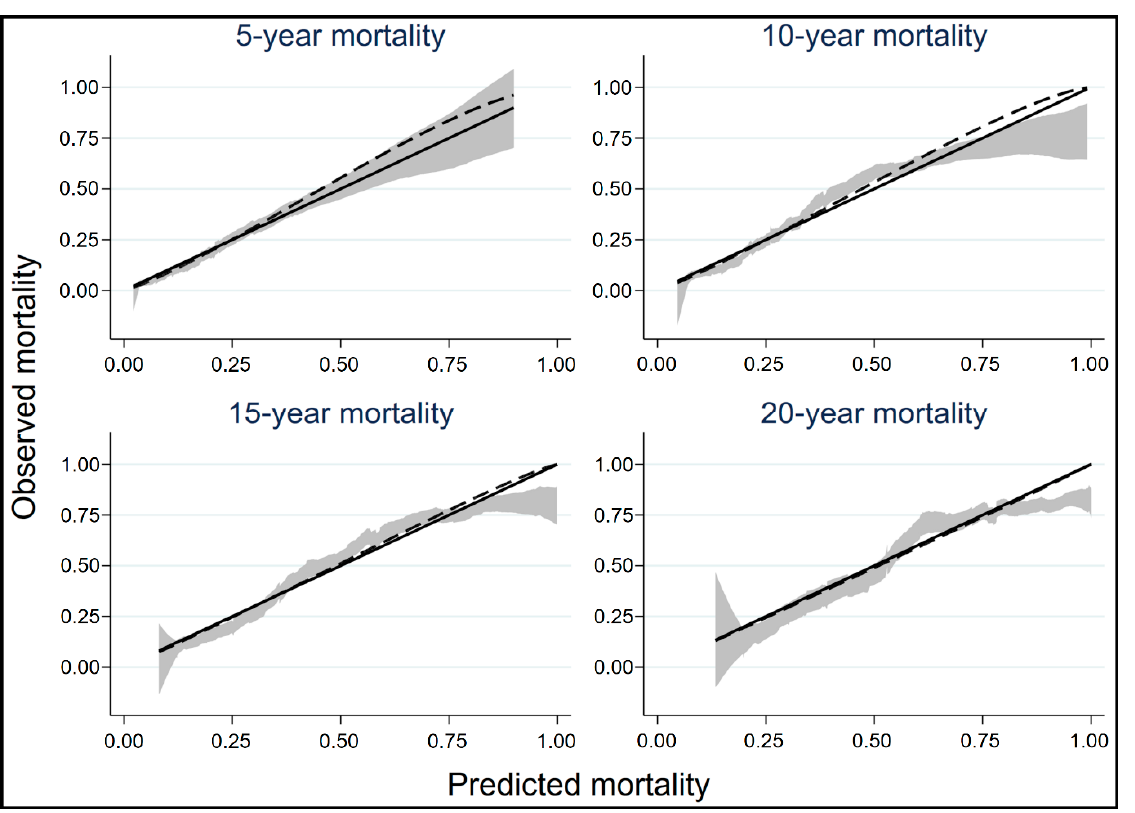
Figure 1. External calibration of the original score in the isolated CABG ‐ BITA dataset at 5, 10, 15 and 20 years with smooth estimates with pointwise 95% confidence intervals plotted against predicted mortality probabilities. The solid line is the line of identity, denoting perfect calibration. Some miscalibration in the large is evident at 5 and 10 years with underprediction of mortality probabilities.